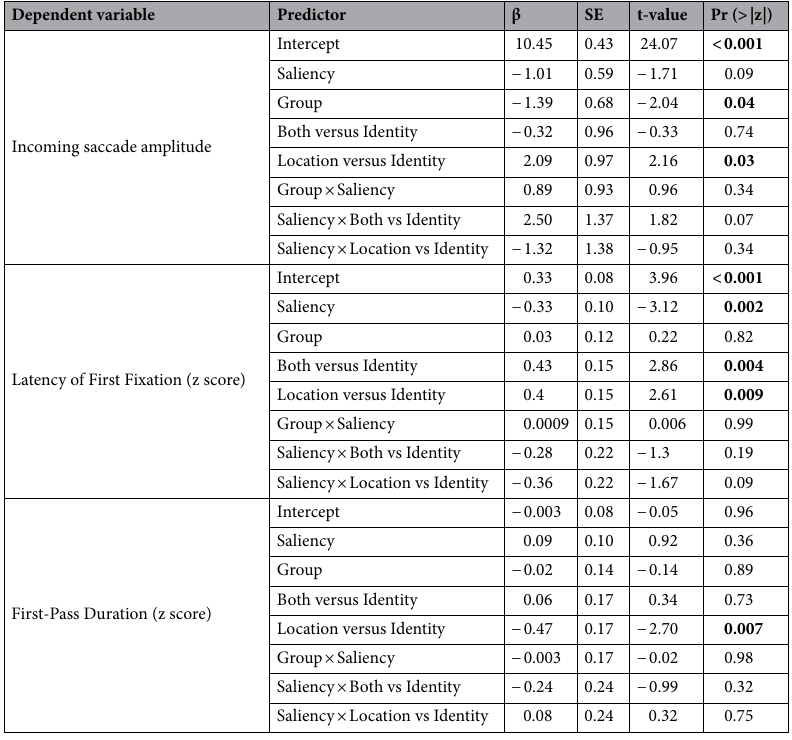
Table 5. Linear mixed effects model output for the effects of saliency on eye-tracking measures on the Current Location during recognition (correct trials only): incoming saccade amplitude, latency to first fixation (z-score) and first-pass gaze duration (z-score) on the critical object. Predictors centred and standardized entered were Saliency, Group (Younger = − 0.5 and Older = 0.5) and Type of Change (Location, Both—Identity as reference level). We report the β , the standard error, the t -value and the p -value. The random effects introduced as intercept were Participants (50) and the unique identifier of Scene item